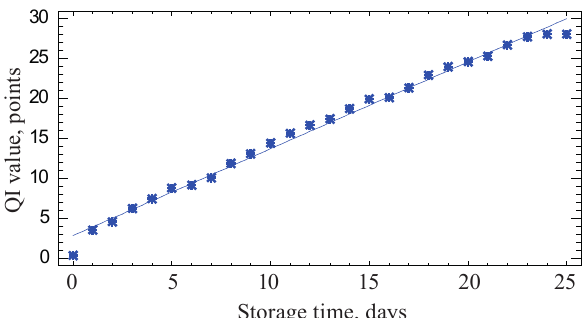
Pinkish body with reddish pigment spots all around the body; strong fishy, foul smell; opalescent white soft flesh; mildly concaved eyes with opalescent corneal, broken pupils; no mucus; flaccid tentacles with suckers completely fallen out.